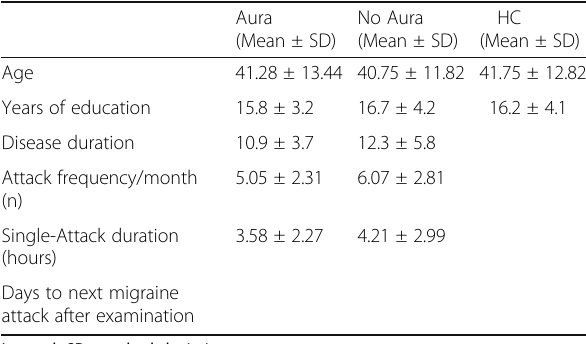
Table 1 Socio-demographic characteristics of patients with aura ( n = 14) without aura ( n = 14) and controls ( n =